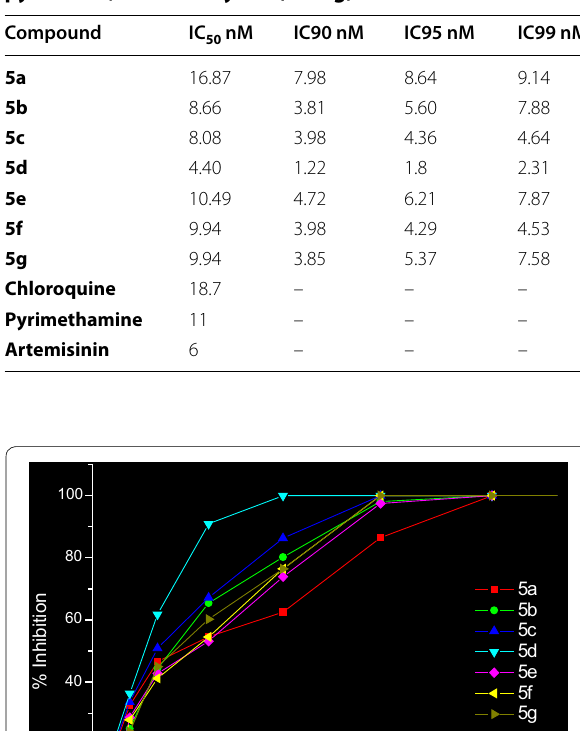
vitro anti-malarial activity of diethyl Table 4 Antimicrobial activity of diethyl